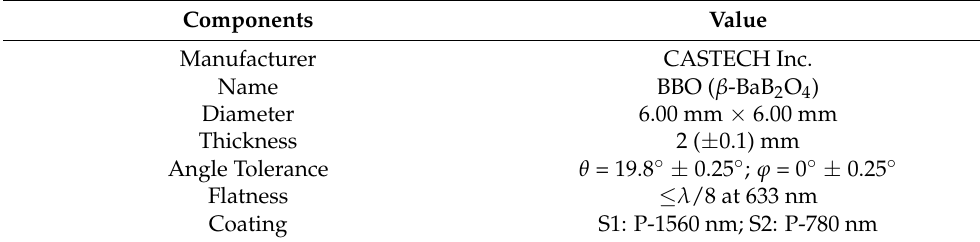
Table 2. BBO crystal